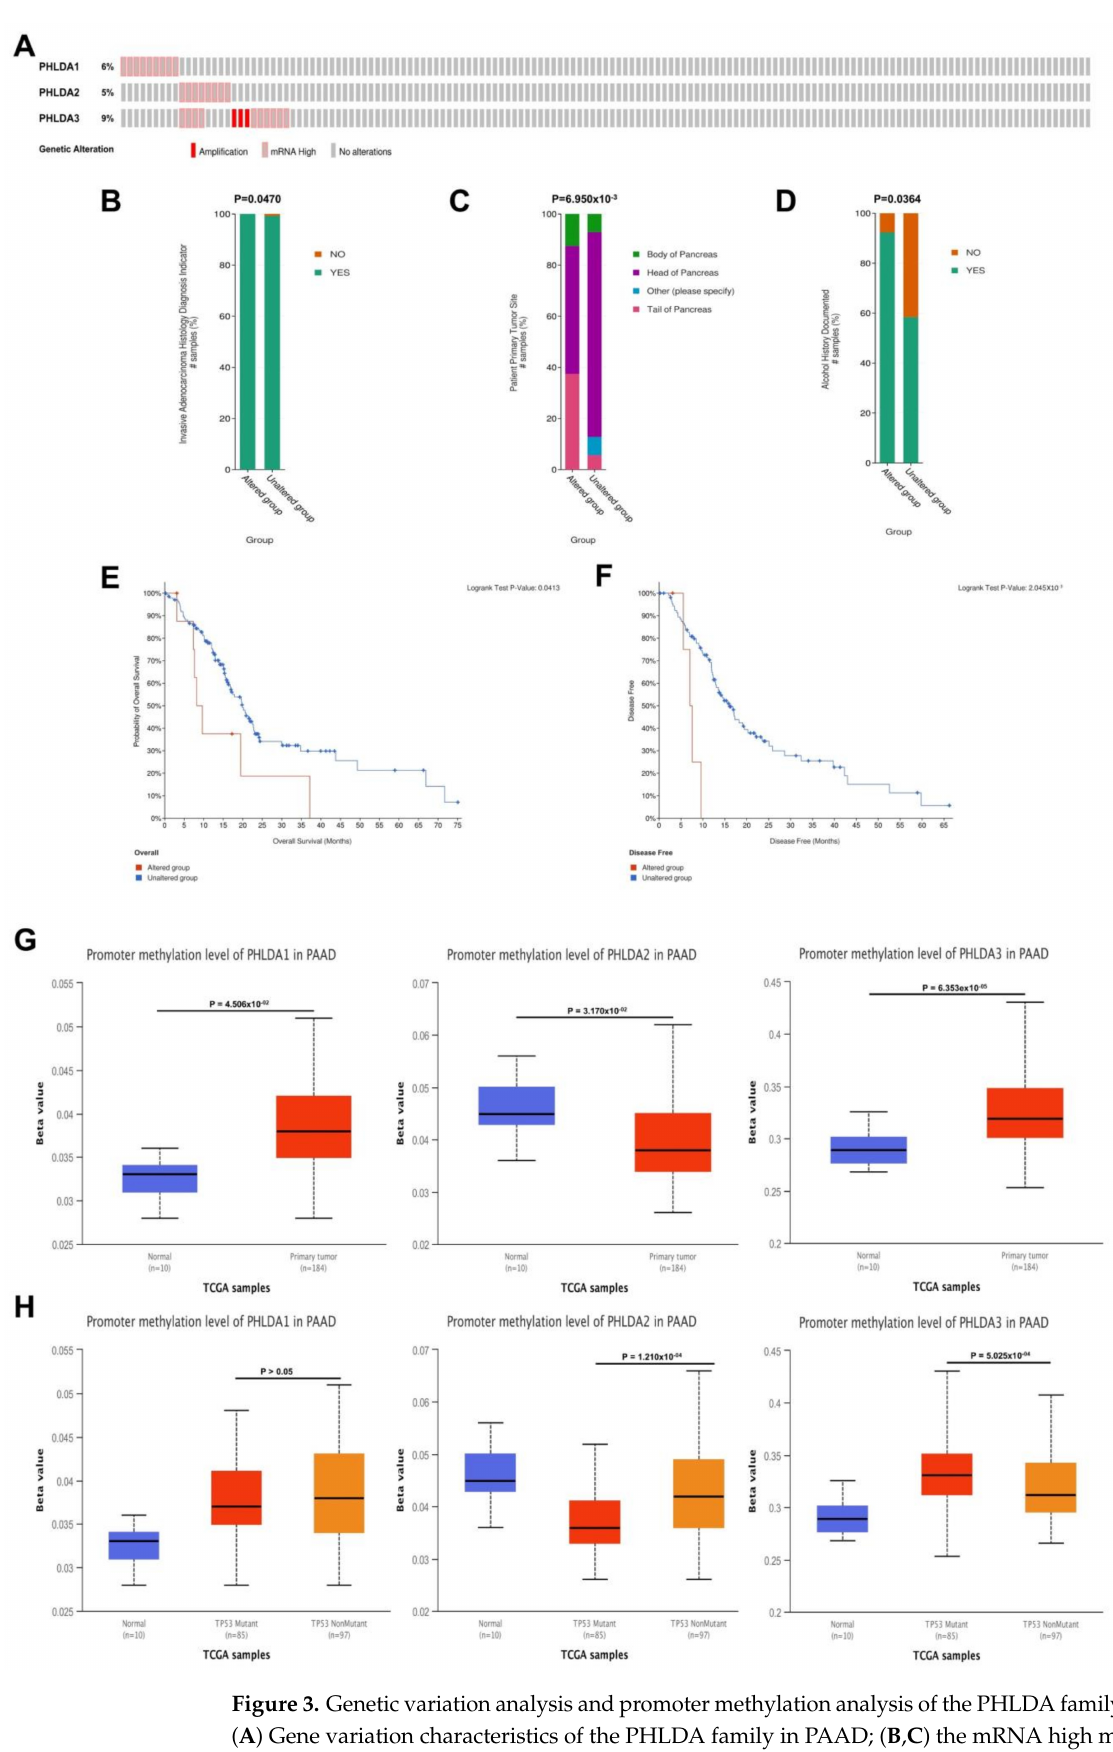
Figure 3. Genetic variation analysis and promoter methylation analysis of the PHLDA family in PAAD. ( A ) Gene variation characteristics of the PHLDA family in PAAD; ( B , C ) the mRNA high mutation